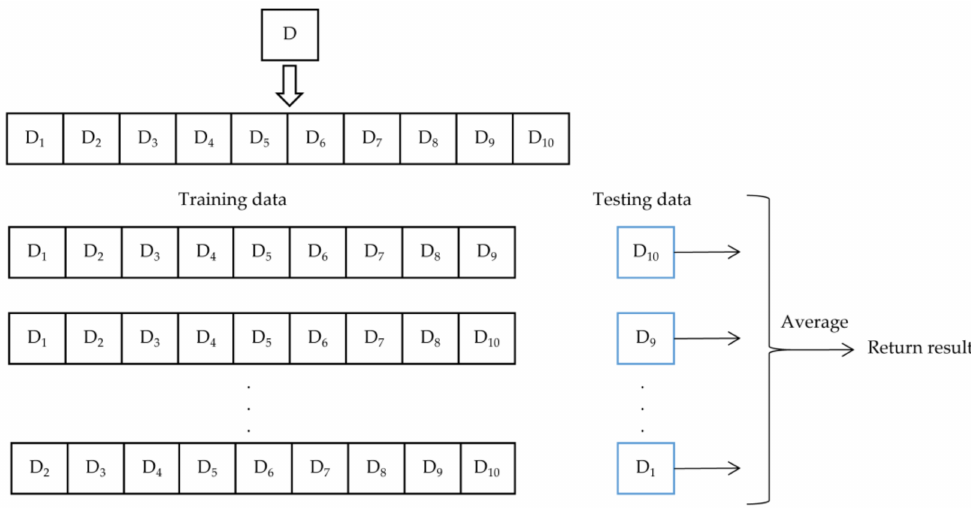
Figure 6. Ten-fold